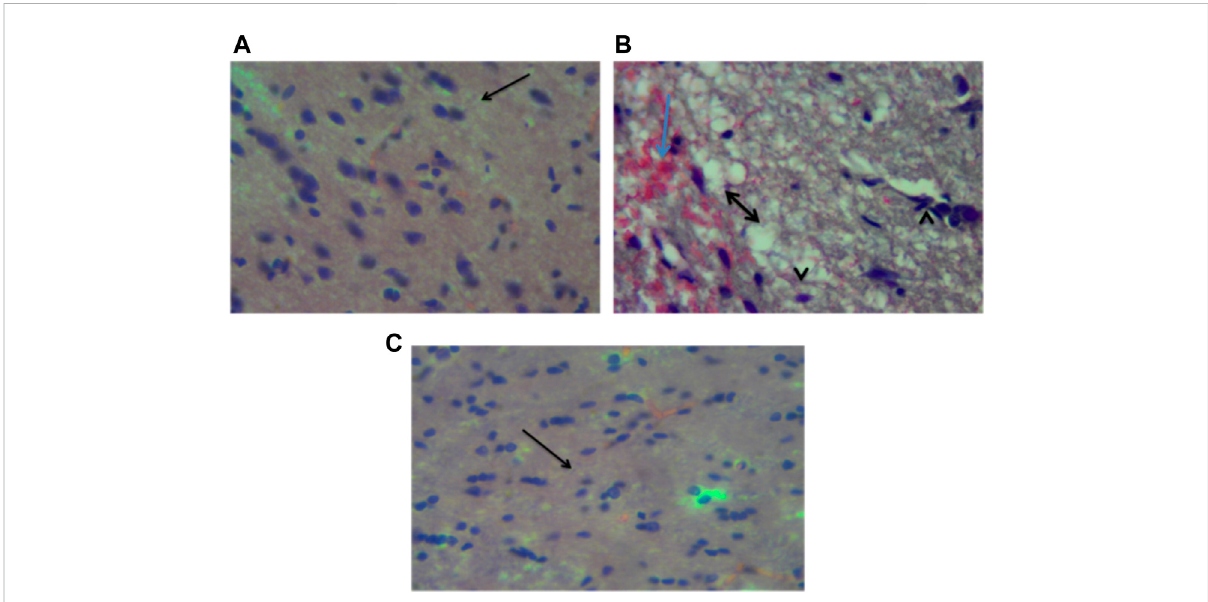
FIGURE 14 Photomicrographof thebrain (cerebrum)of (A) Non traumatizednon treated(GroupIII) rats showing normal neuronsof thecerebrum (arrow), (B) Traumatized nontreated(GroupII)showingspongiosis (doubleheadarrow),hemorrhages(blue arrow) andnecrosis oftheneurons(arrowhead), (C) DMO treated rats (Group I) showing normalization of neuronal cells, H and E, X40